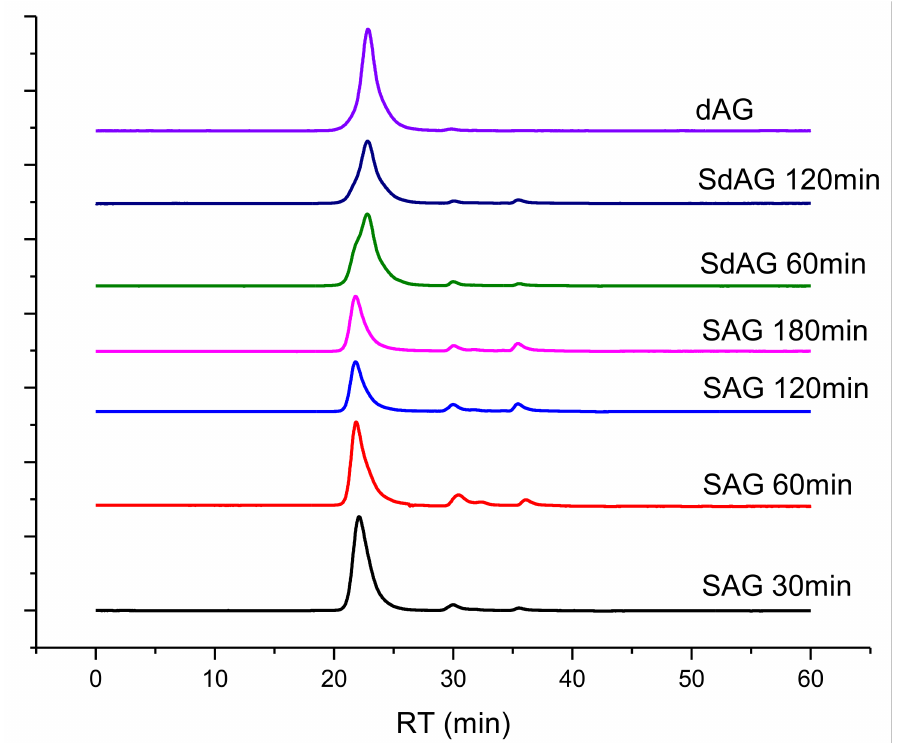
Figure 6. Gel permeation chromatograms of the sulfated arabinogalactan samples after dialysis (temperature of 85 ◦ C and the ratio of the amount of the complex to the amount of the polysaccharide corresponds to 1:15). Table 5. MWD for the samples of the reaction mass sulfated at a temperature of 85 ◦ C, the ratio of the amount of the complex to the amount of the polysaccharide corresponds to 1:15. Sample